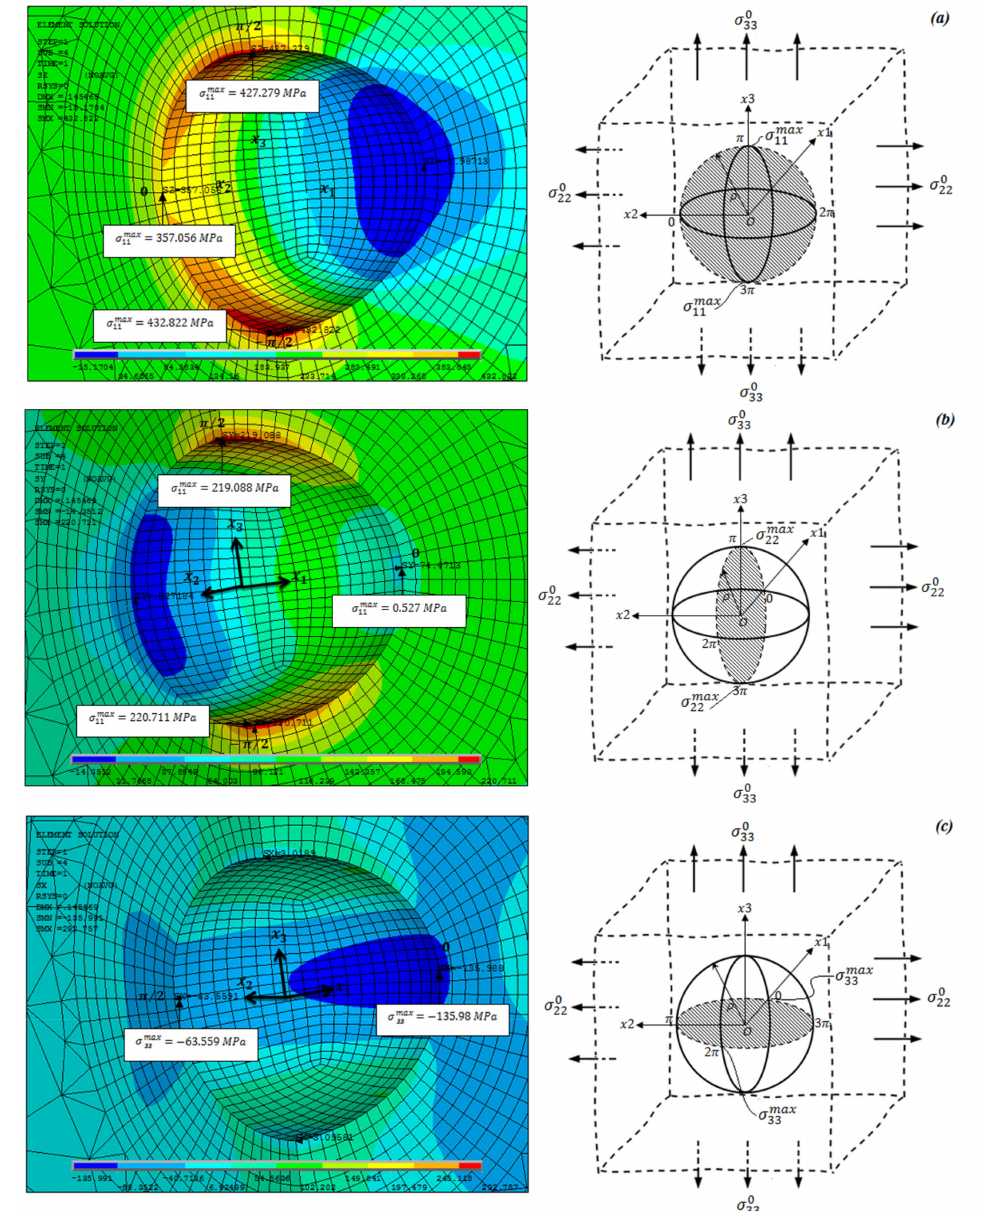
Figure 8. Repartition of the components of stress around the spherical cavity and the stress values at θ = 0, π /2, and − π /2, ( a ) component of hoop stress σ 11 , ( b ) component of axial stress σ 22 , and ( c ) component of radial stress σ 33